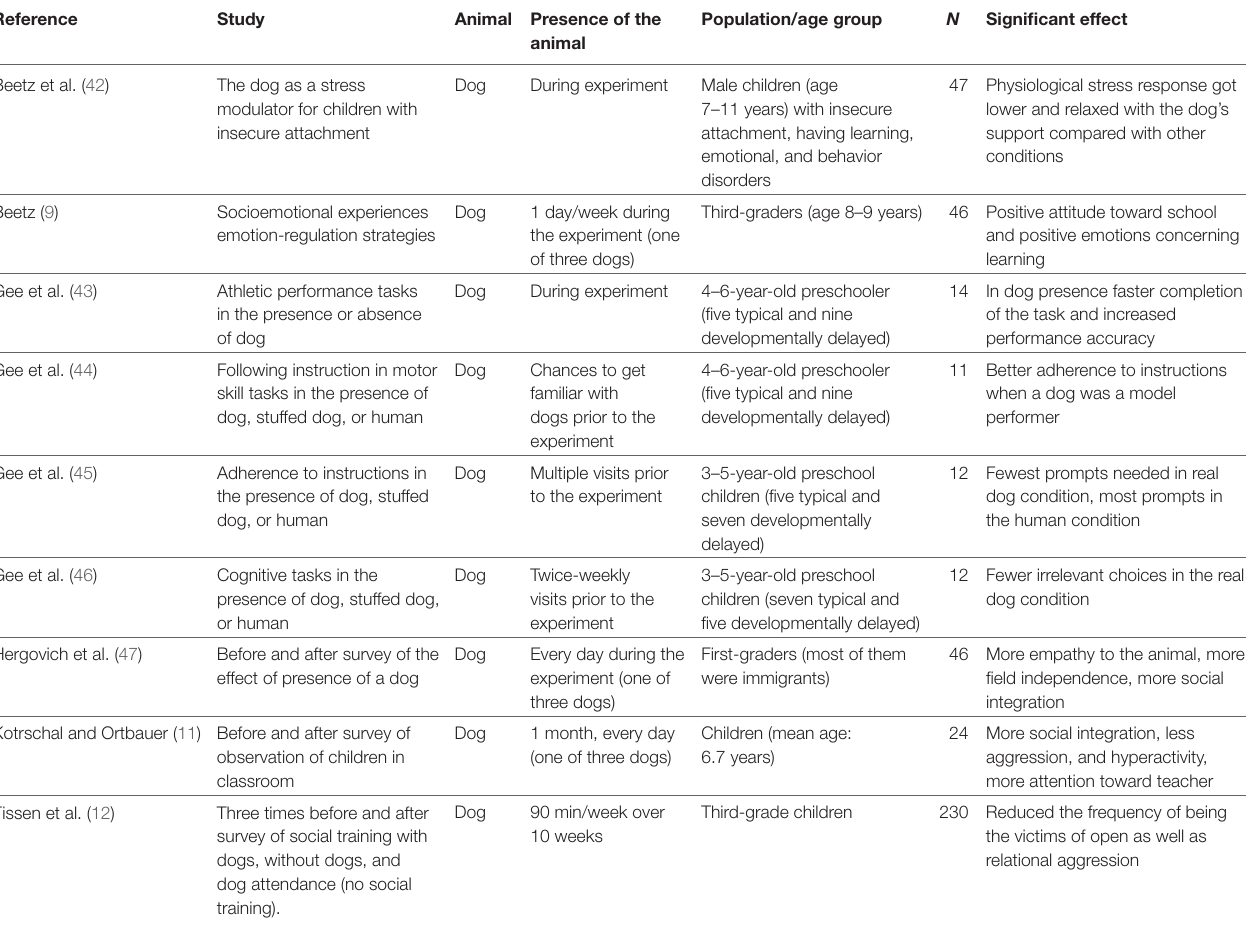
TAbLe 1 | Original studies included in the review of conventional animal-assisted